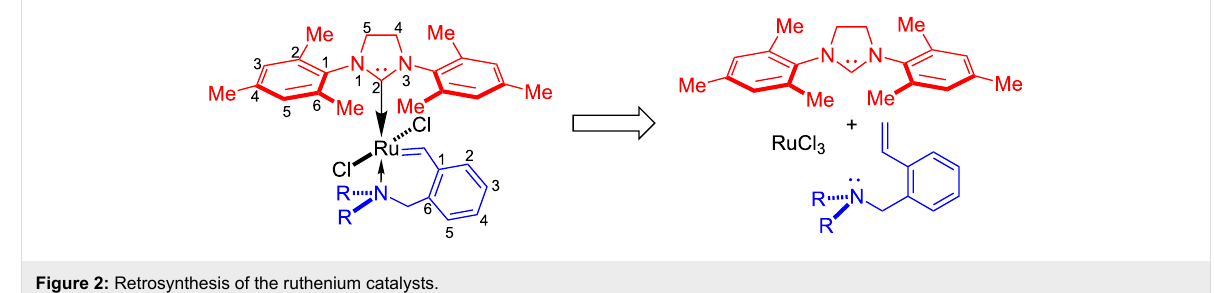
Figure 2: Retrosynthesis of the ruthenium catalysts.